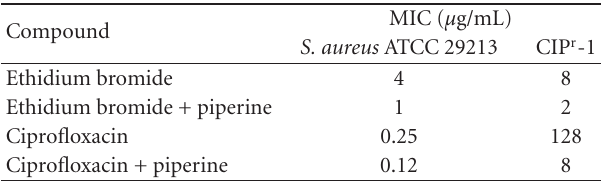
Table 12: E ff ect of piperine on plasma concentration of ampicillin in rabbits [95].